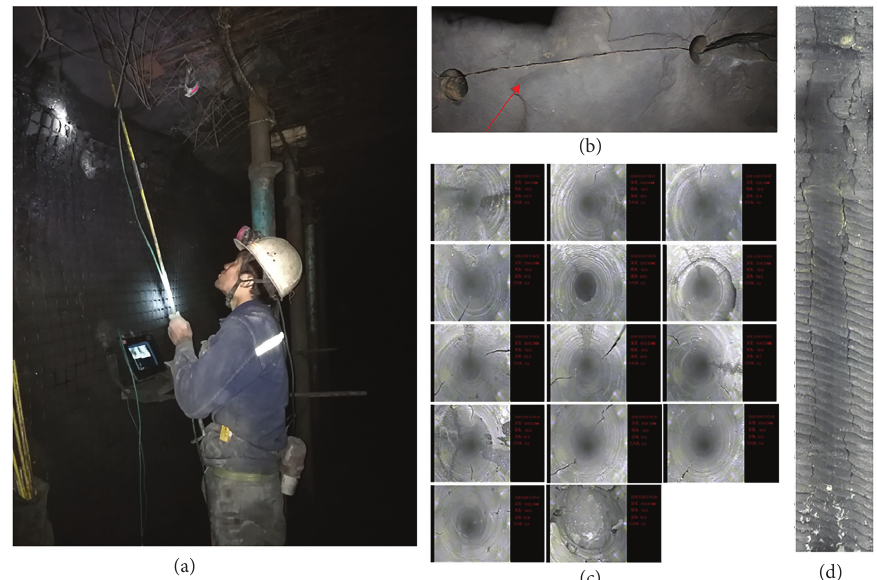
Figure 13: Roof-cut presplitting blasting inspection. (a) The actual operation of underground workers to check the effect of presplit blasting in the hole. (b) The effect of the roof surface after the roof is precracked. (c, d) The effect of presplitting and cracking in the